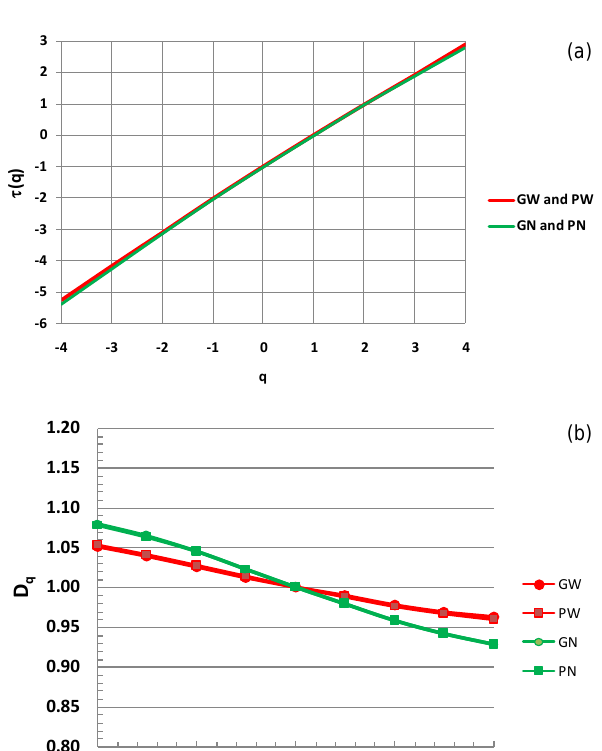
Figure 6. Multifractal analysis of the four variables studied: (a) function τ(q) versus q ; (b) derived generalized dimensions ( D q ) from τ(q) . The plotted variables are grain nitrogen content (GN), grain weight (GW), wheat nitrogen content (PN) and wheat weight